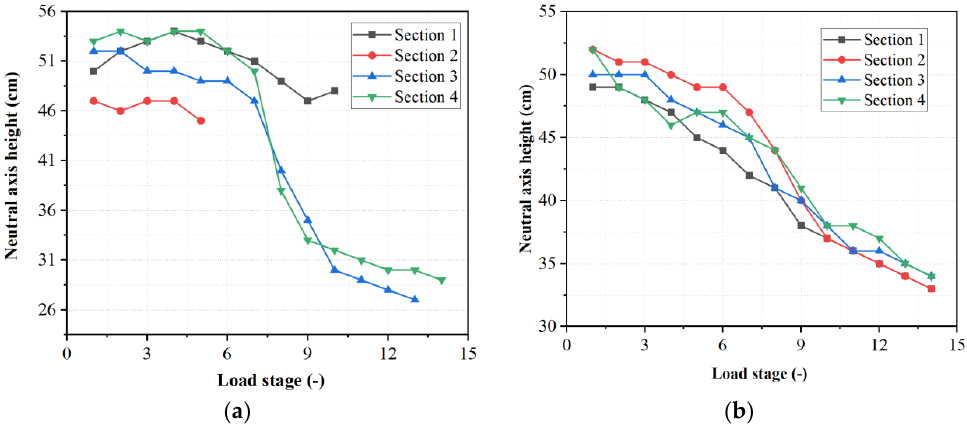
Figure 13. Neutral axis height variation under different loads: ( a ) PSCBC; ( b ) CICBC.